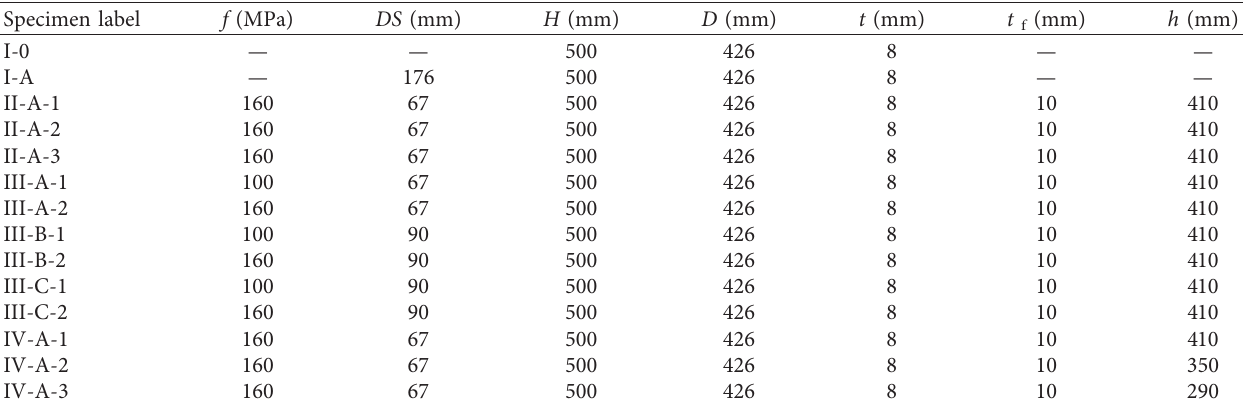
Figure 2: Design drawings of new replaceable tubular steel piers (units: mm). (a) Cross section of specimen I-0. (b) Cross section and expanded view of type I-A specimens. (c) Cross section and expanded view of type II-A specimens. (d) Cross section and expanded view of type III-A specimens. (e) Cross section and expanded view of type III-B specimens. (f) Cross section and expanded view of type III-C specimens. (g) Cross section and expanded view of type IV-A Table 1: The design parameters of axially compressed specimens.